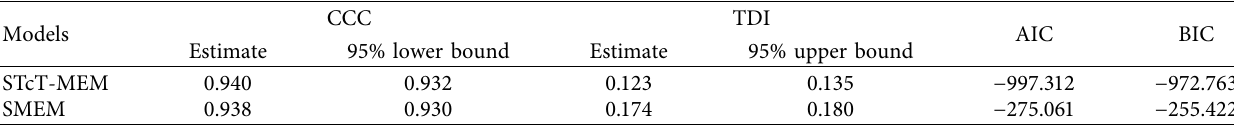
Table 5: Measures of agreement and model selection criteria for gold particle